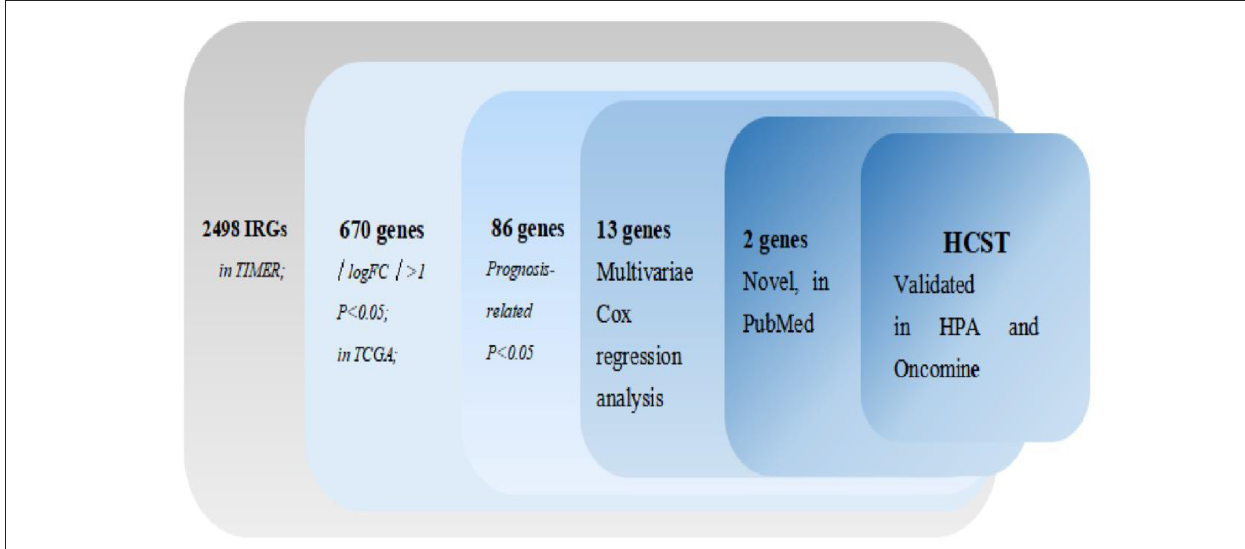
FIGURE 1 | Procedure for the selection of diagnosis and prognosis biomarkers for ccRCC.